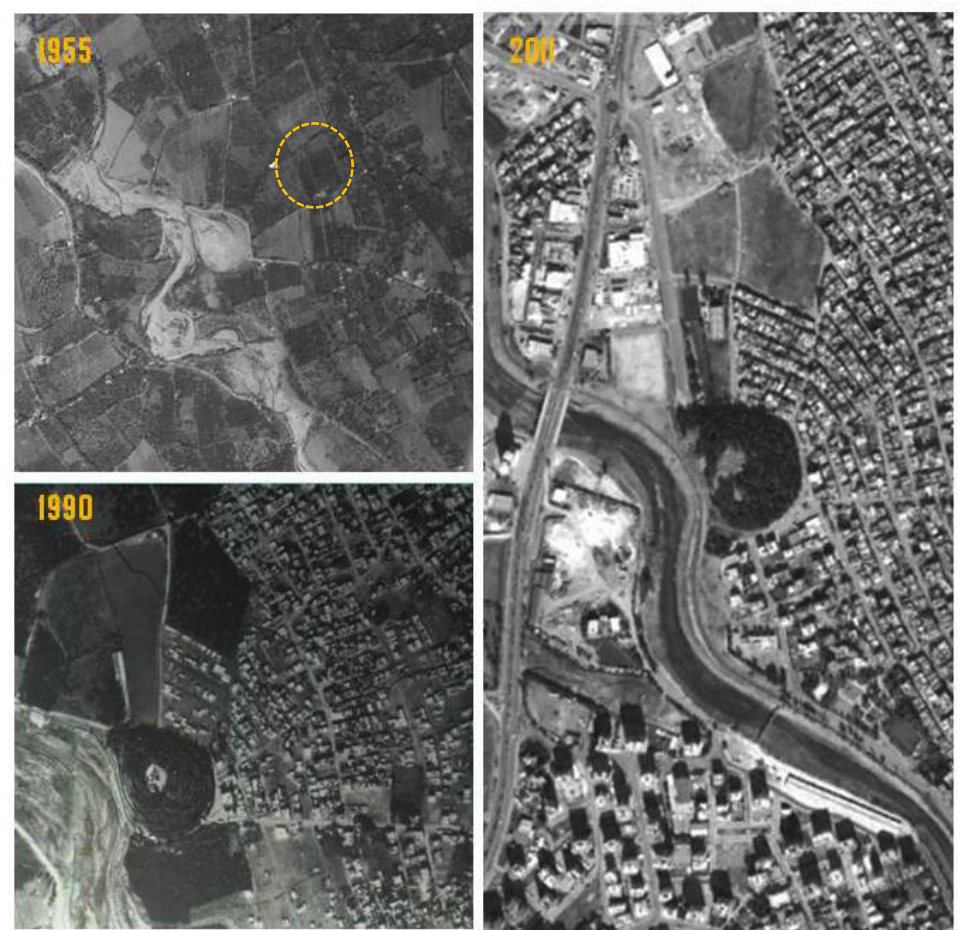
Figure 2 Urban development process around Yumuktepe Mound through 1955, 1990 and 2011 (Naycı,